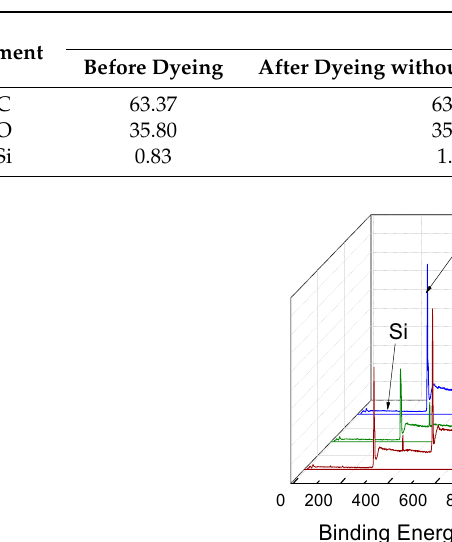
Figure 7. Wide scan XPS of PET fiber before and after dyeing ( 1 : B\before dyeing. 2 : after dyeing without adding accelerant, 3 : after dyeing with accelerant).